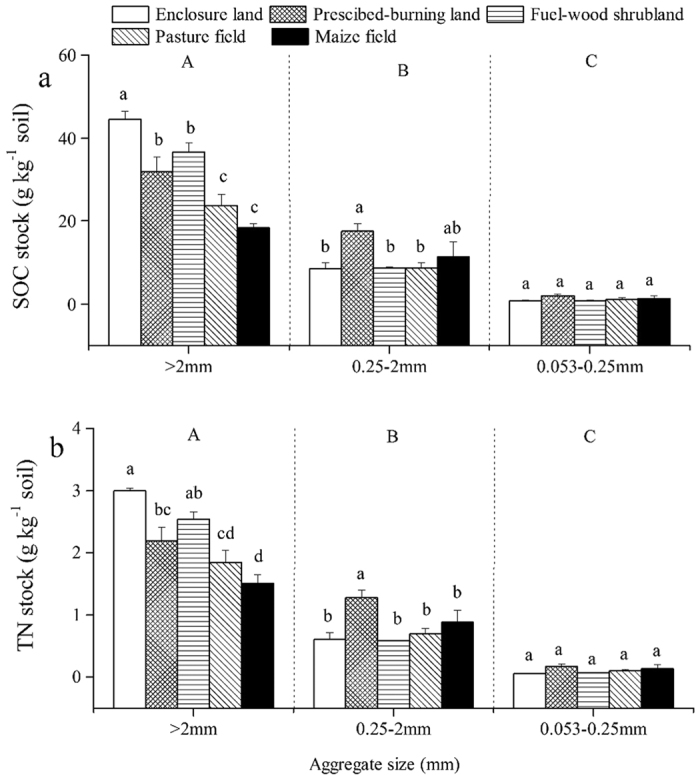
Soil organic carbon (SOC) (a) and total nitrogen (TN) (b) stocks in the three sizes of soil aggregates and in bulk soil of different land uses. Values are means of three replicates (± standard error). Different lowercase letters indicate significant differences among land uses for each size of soil aggregate and for bulk soil. Different uppercase letters indicate significant differences among the three sizes of soil aggregates.